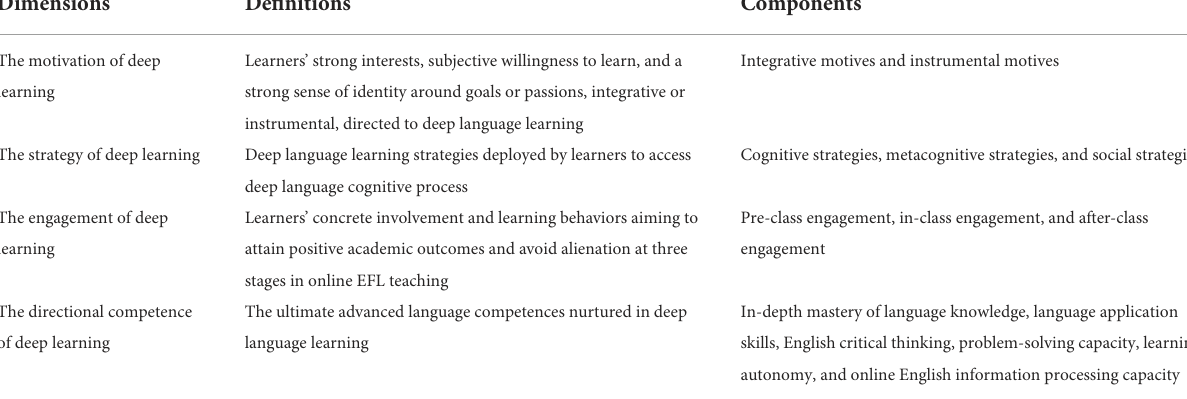
TABLE 11 The four dimensions of the deep learning model in the online EFL teaching